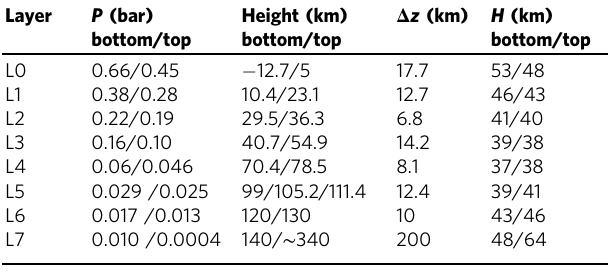
Table 1 Location and thickness of the haze layers.